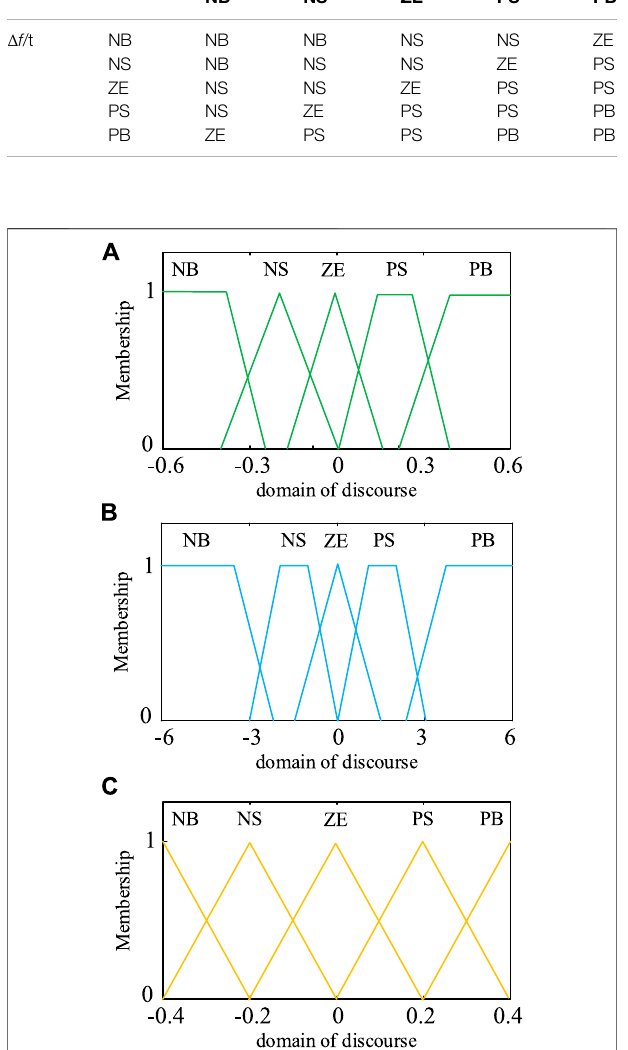
FIGURE 7 | Membership function of each variable. (A) The af fi liation functionofthefrequencydeviationquantity Δ f . (B) Theaf fi liationfunctionofthe rate of change of frequency d Δ f/dt. (C) The af fi liation function of the output Δ k λ .